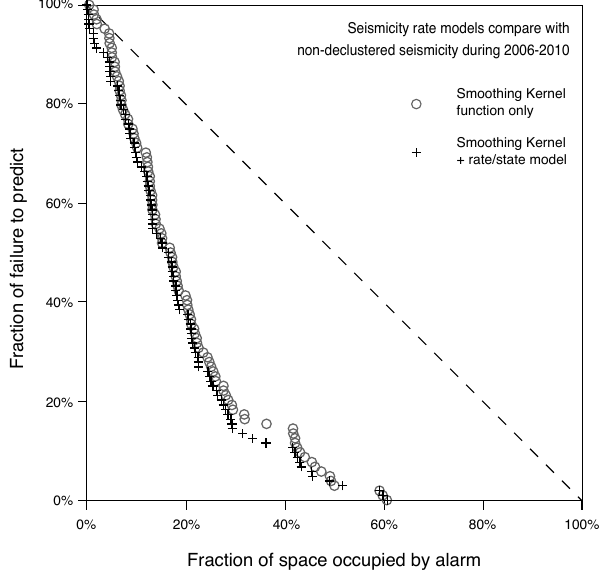
Fig. 9. A Molchan diagram that investigates the correlation between seismicity rate models and non-declustering seismicity during the forecasting period (2006–2010). Gray circles represent the correla- tion with the long-term rate model using the smoothing Kernel func- tion. Black crosses represent the correlation with the short-term rate model according to a combination of the smoothing Kernel function and the rate-and-state friction model.